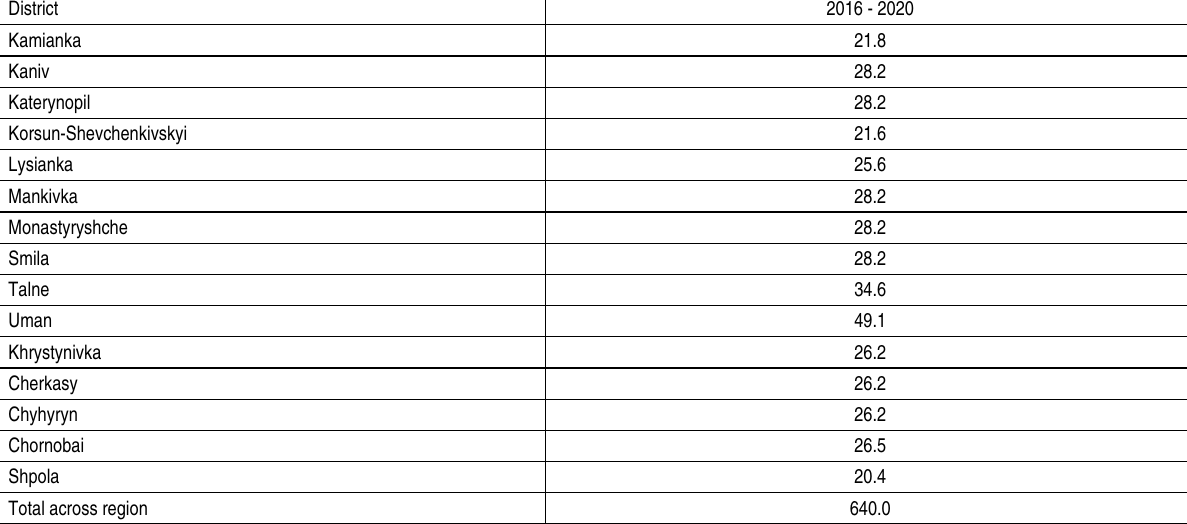
Table 5 (cont.). Recommended amounts of green manure crop in Cherkasy region, the hectares